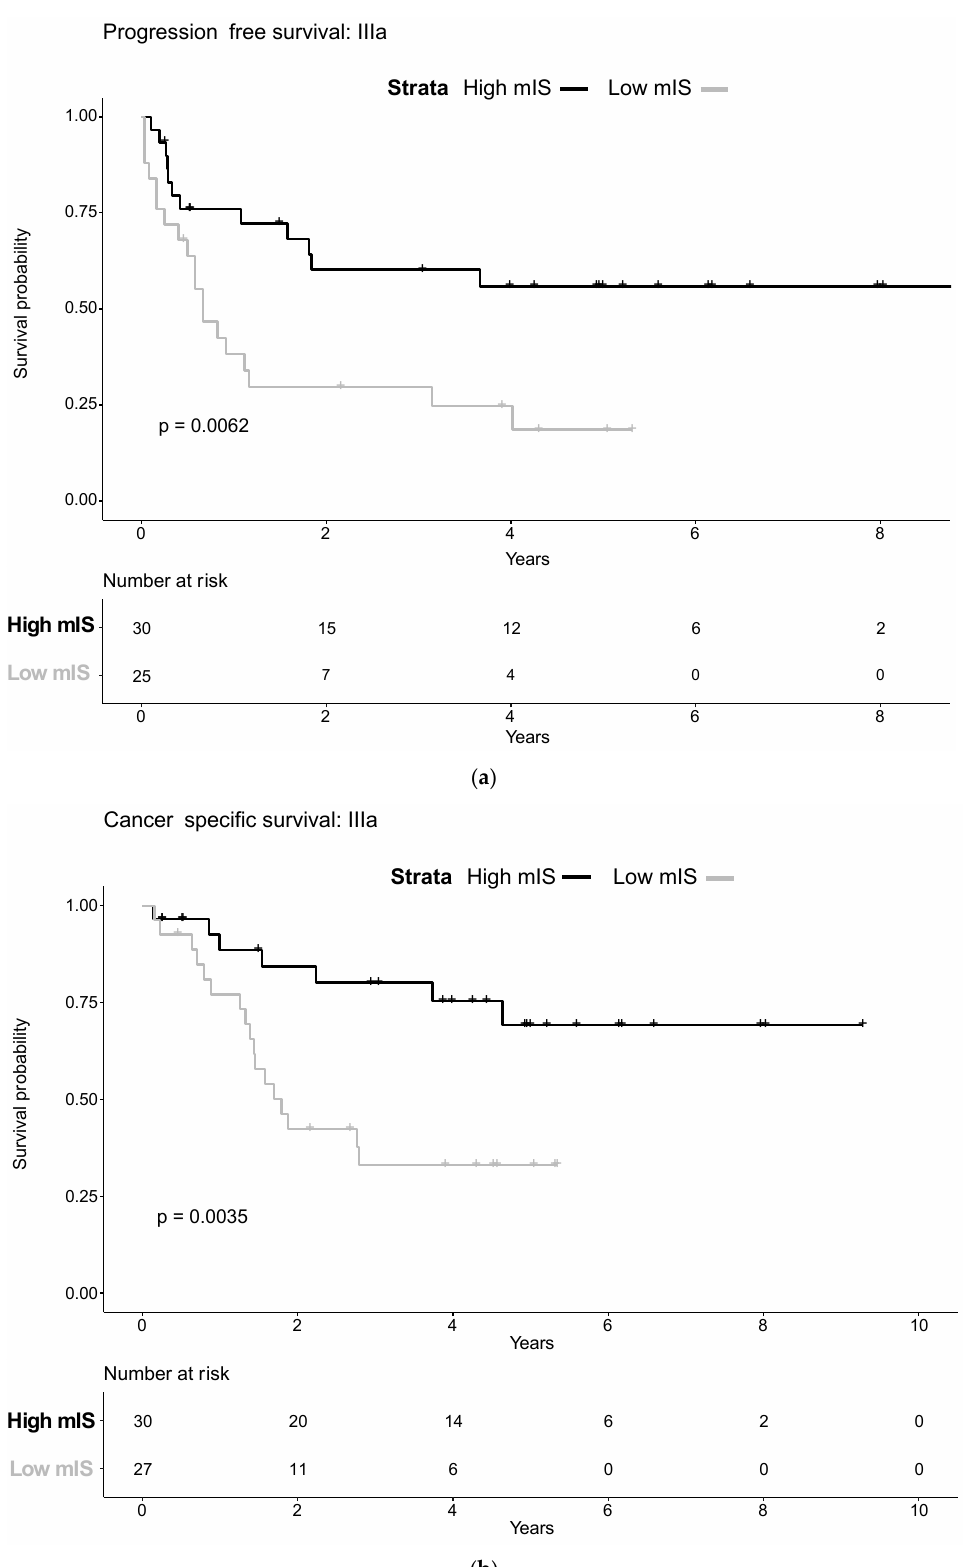
Figure 3. ( a ). Kaplan–Meier curve of progression-free survival for high mIS (black line) and low mIS (grey line) in AJCC-stage IIIa. ( b ). Kaplan–Meier curve of cancer-specific survival for high mIS (black line) and low mIS (grey line) groups in AJCC-stage